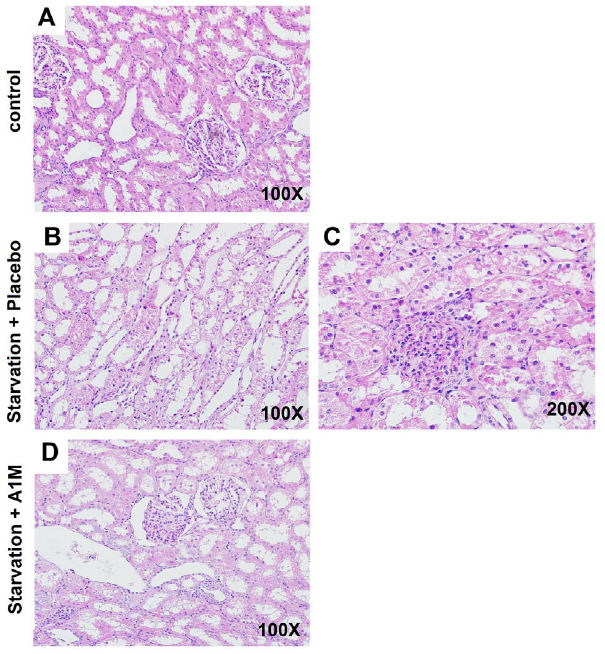
Figure 7. Renal histology in starved, placebo-treated ewes. The renal tissue was studied using light microscopy in cortical specimens stained with hematoxylin and eosin. A. Normal cortical tissue morphology is shown. The renal tubules show minor signs of postmortal changes but the height of the epithelium is normal, and only discrete cytoplasmal vacuolizations are seen. The glomeruli demonstrate open capillary loops and no signs of segmentation (magnification 100 6 ). B and C. Distinct signs of acute tubular necrosis (ATN) are evident in the form of sloughing of apical plasma membranes and tubular cells into the lumen. In addition, a reduced epithelial height can be seen (B, 100 6 magnification). There are also signs of glomerular endothelial swelling seen from the closure of capillary loops and a non- isometric vacuolization of the tubular epithelium can be seen (C, 200 6 magnification). D. In the A1M-treated ewes, only small tubular changes compatible with ATN are present, but to a milder degree than in the placebo treated group. Also, no signs of glomerular endothelial swelling can be seen (100 6 magnification).